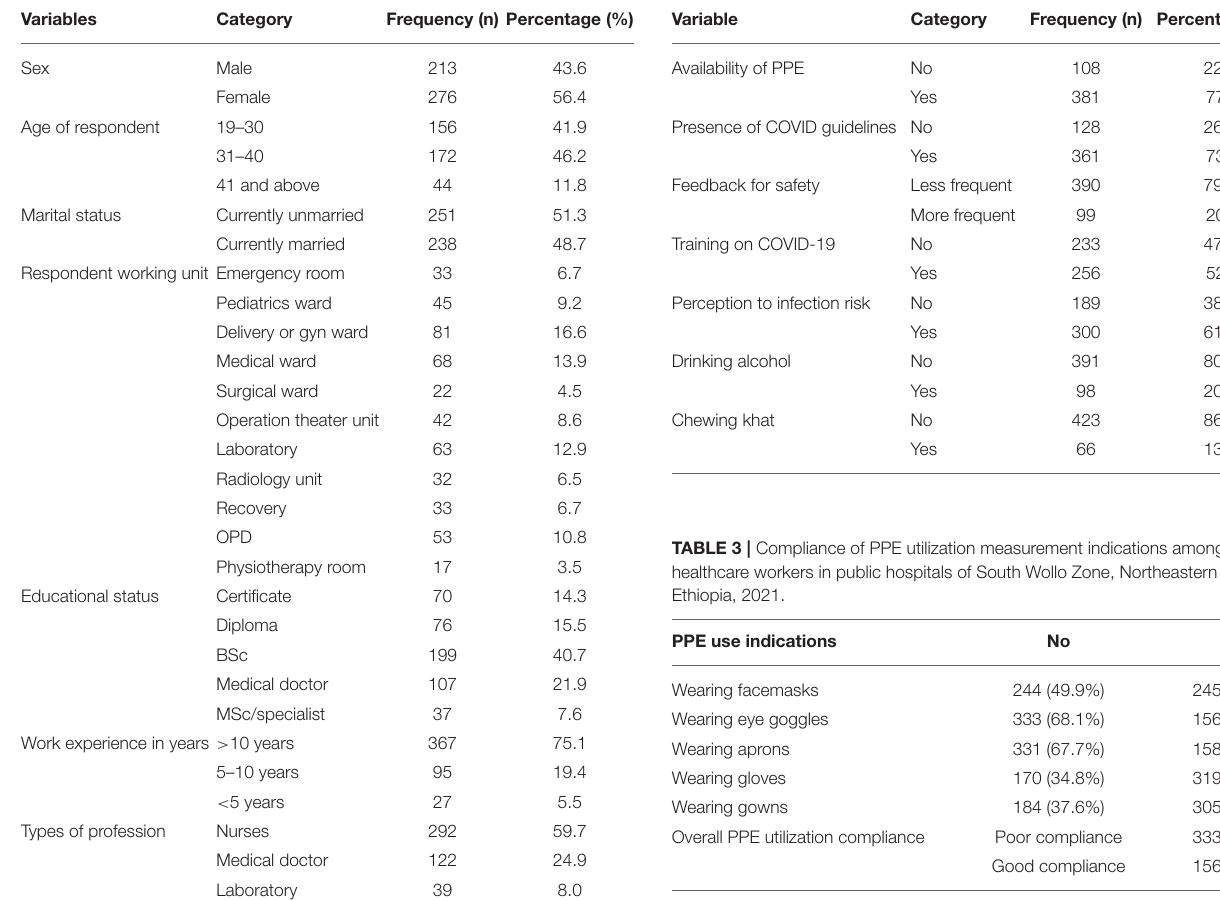
TABLE 2 | Institutional and behavioral factors of healthcare workers in public hospitals of South Wollo Zone, Northeastern Ethiopia, 2021.